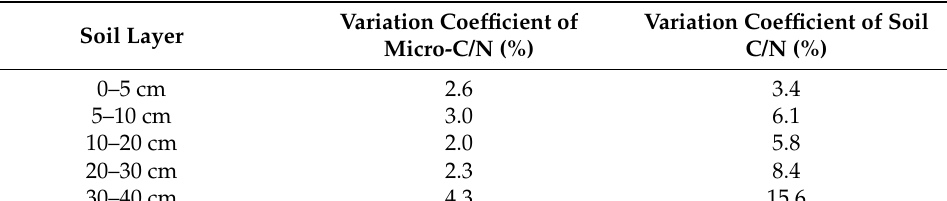
Table 3. Characteristics of carbon (C) and nitrogen (N) stoichiometry in soil and soil microorganisms in different soil layers.